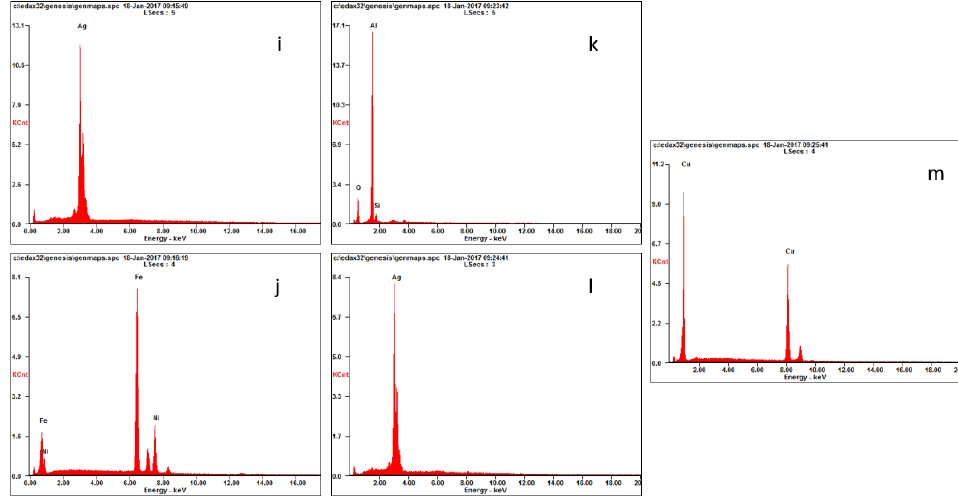
Figure 5. EDS spectra corresponding to Figure3 (The label of each spectra is corresponding to the same label in Figure 3D,E).